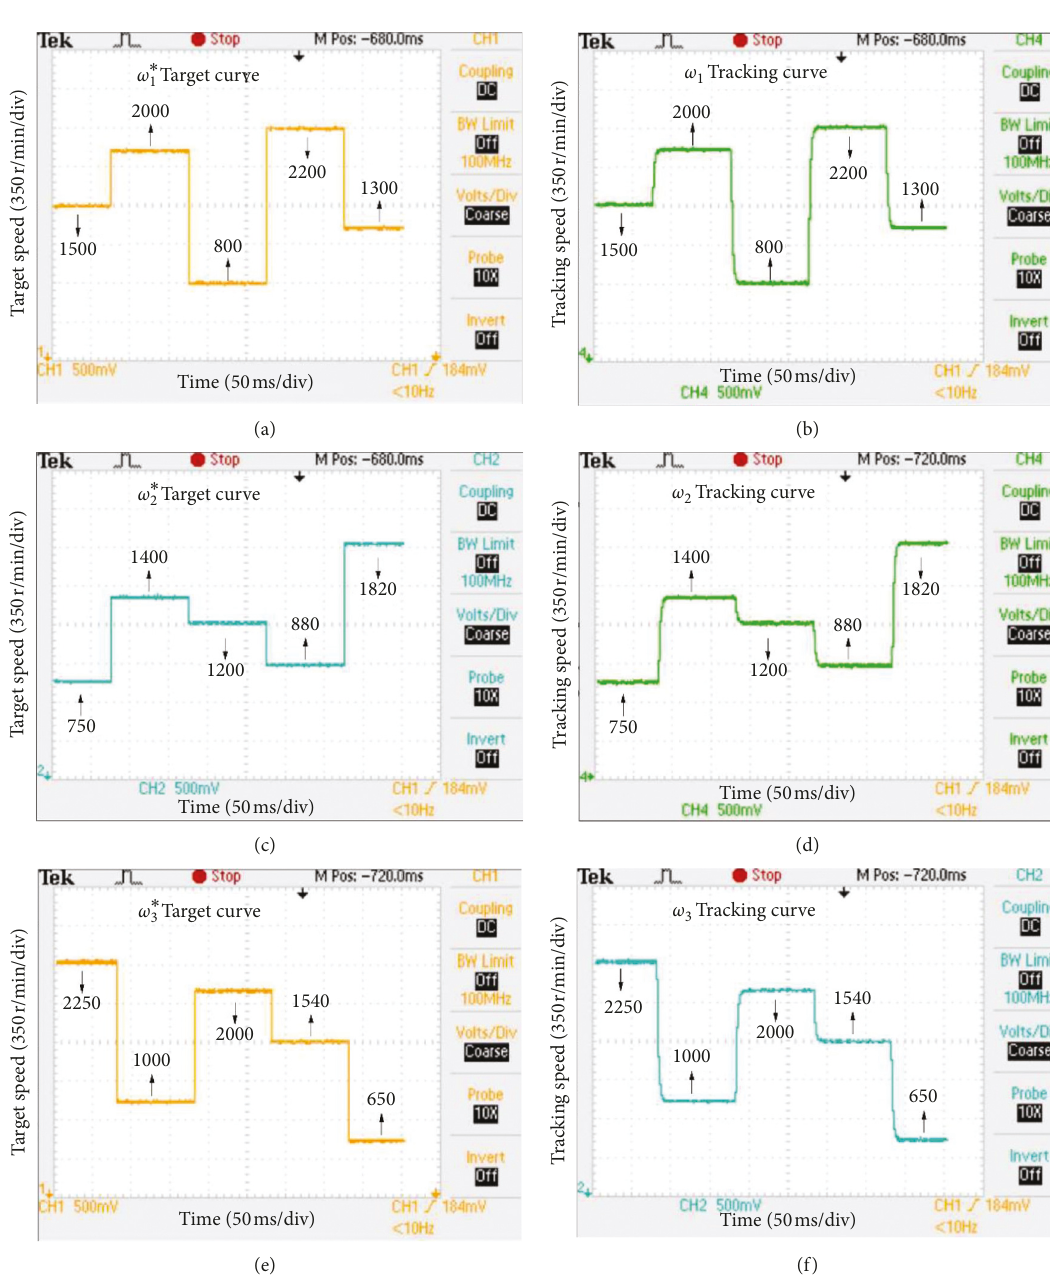
Figure 19: The velocity tracking curves of all servos. (a) The first servo’s target speed. (b) The first servo’s tracking speed. (c) The second servo’s target speed. (d) The second servo’s tracking speed. (e) The third servo’s target speed. (f) The third servo’s tracking